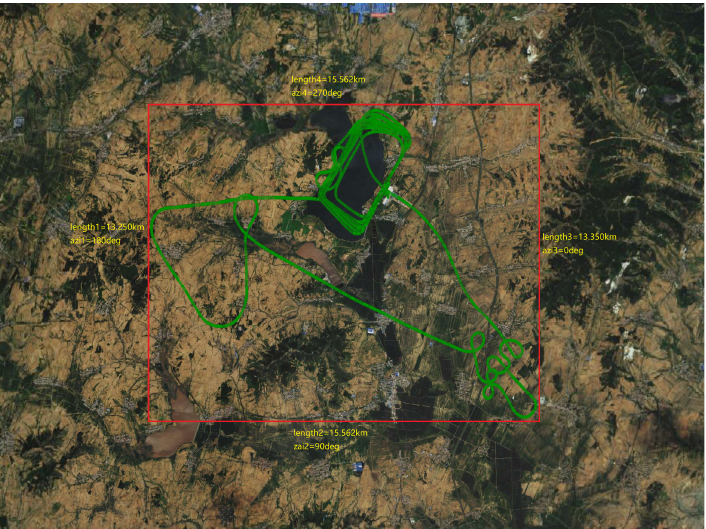
Figure 14. Flight trajectory of test-II. The green line is the trajectory, while the flight distance and azimuth are marked by the red line and the yellow text.